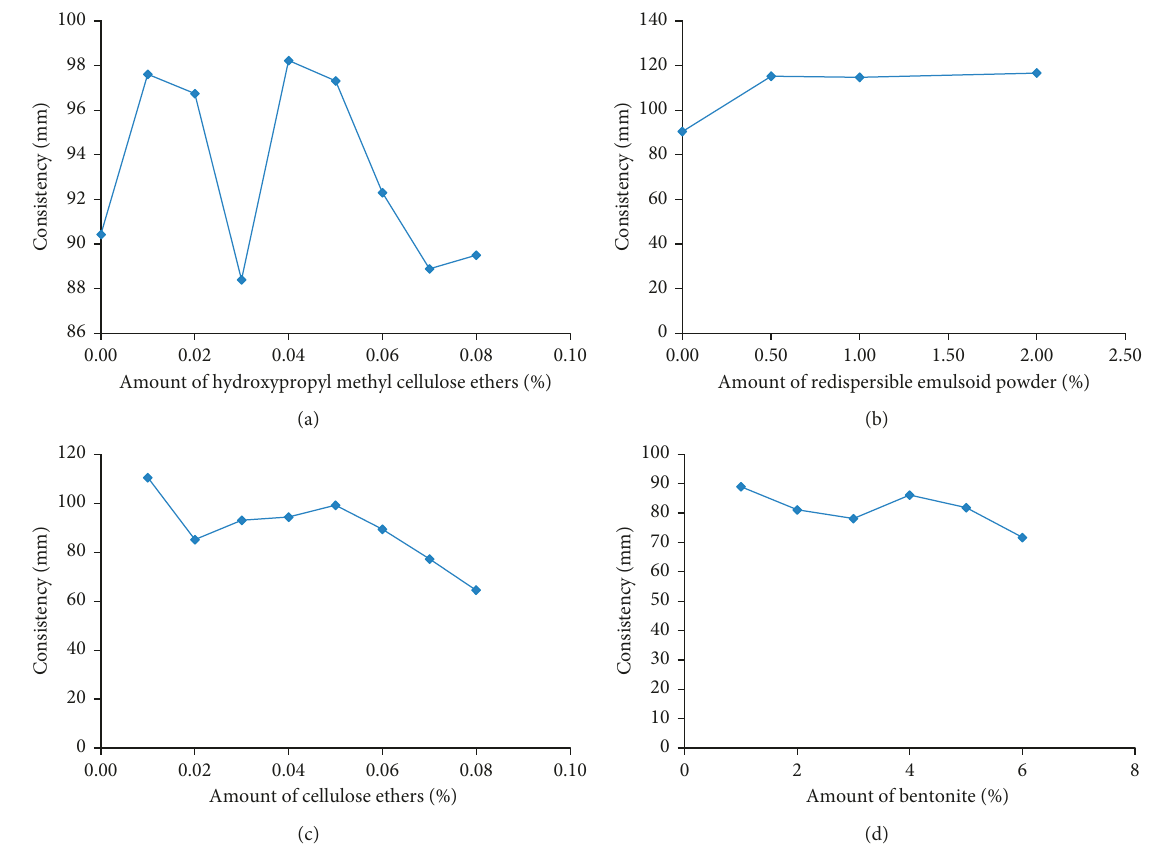
Figure 5: Influence of admixtures on the mortar consistency. (a) Hydroxypropyl methyl cellulose ethers. (b) Redispersion emulsoid powder. (c) Starch ethers. (d)